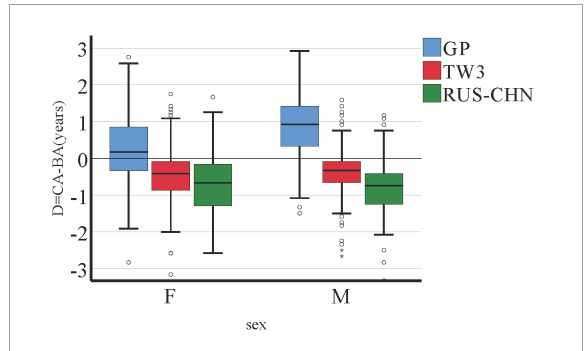
FIGURE2 Boxplots of D = CA (chronological age) - BA (bone age), by